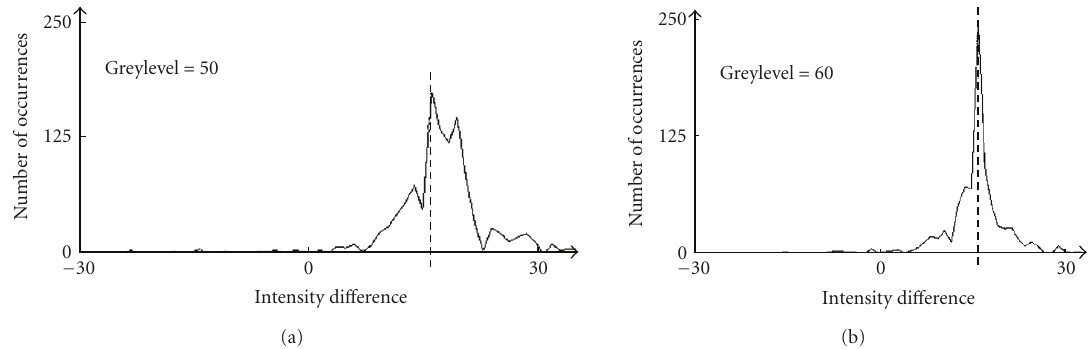
Figure 5: Intensity di ff erence histograms H t ,ref (50) and H t ,ref (60) and their maxima for two consecutive frames of test sequence Caption